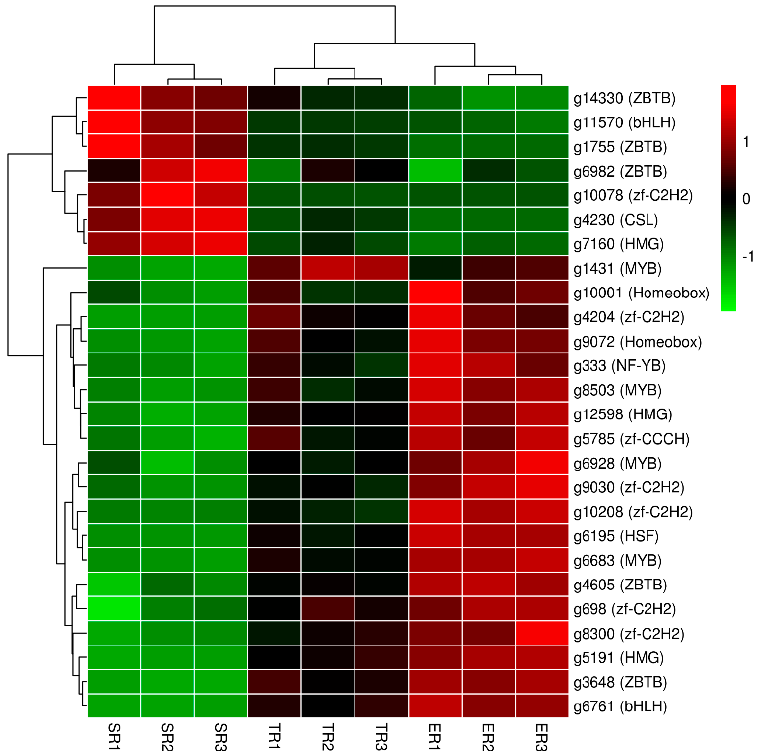
Figure 5. Heatmap of 26 Transcription factors in different stipe regions. Gene expression values (FPKM) were transformed to Z-score values.